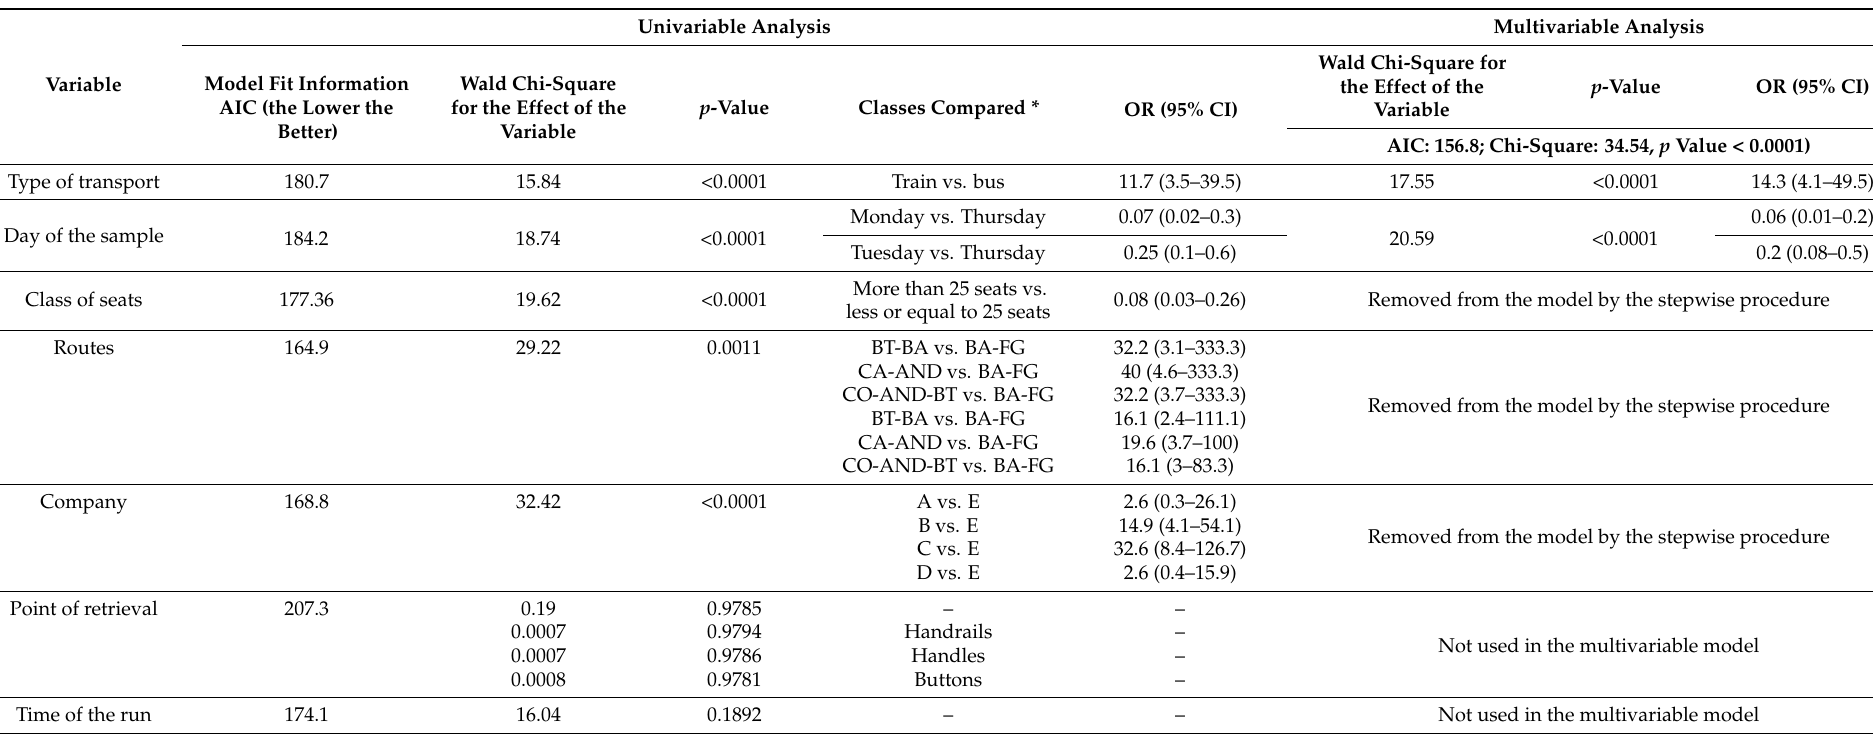
Table 2. Results of the univariable and multivariable logistic models to evaluate effect of main characteristics of the tested